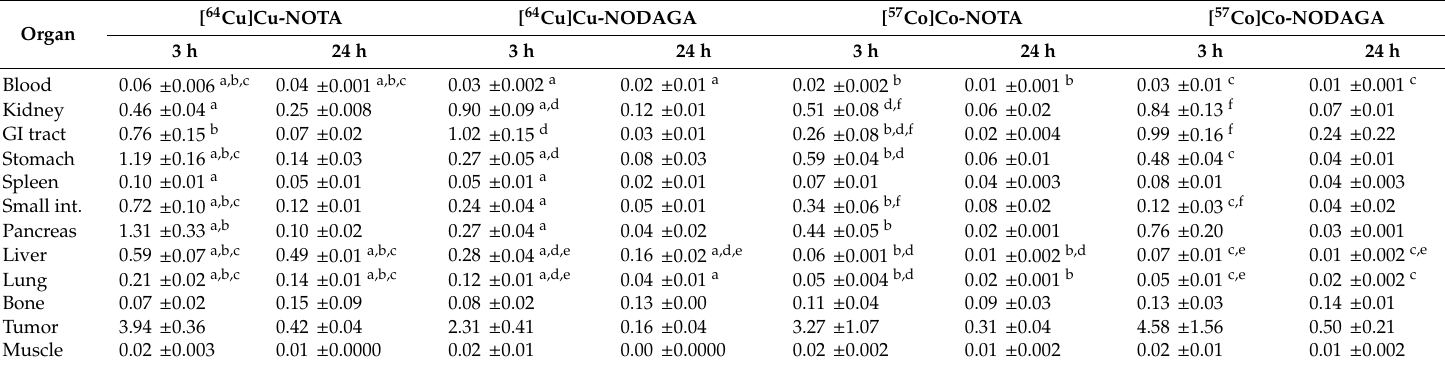
Table 2. The biodistribution results for [ 64 Cu]Cu-X-RM26 and [ 57 Co]Co-X-RM26 (X = NOTA-PEG 2 and NODAGA-PEG 2 ) in BALB C / nu mice at 3 and 24 h p.i.